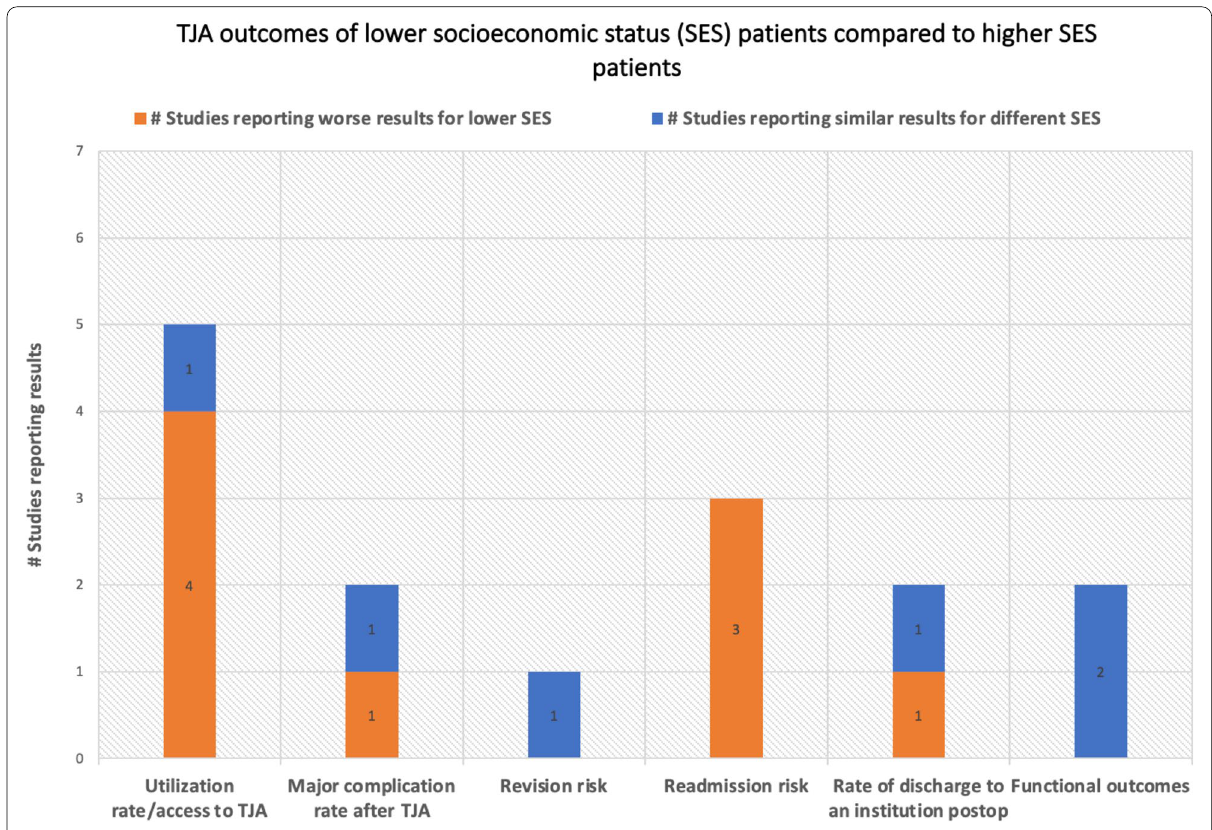
Fig. 4 TJA outcomes of lower SES patients compared to higher SES